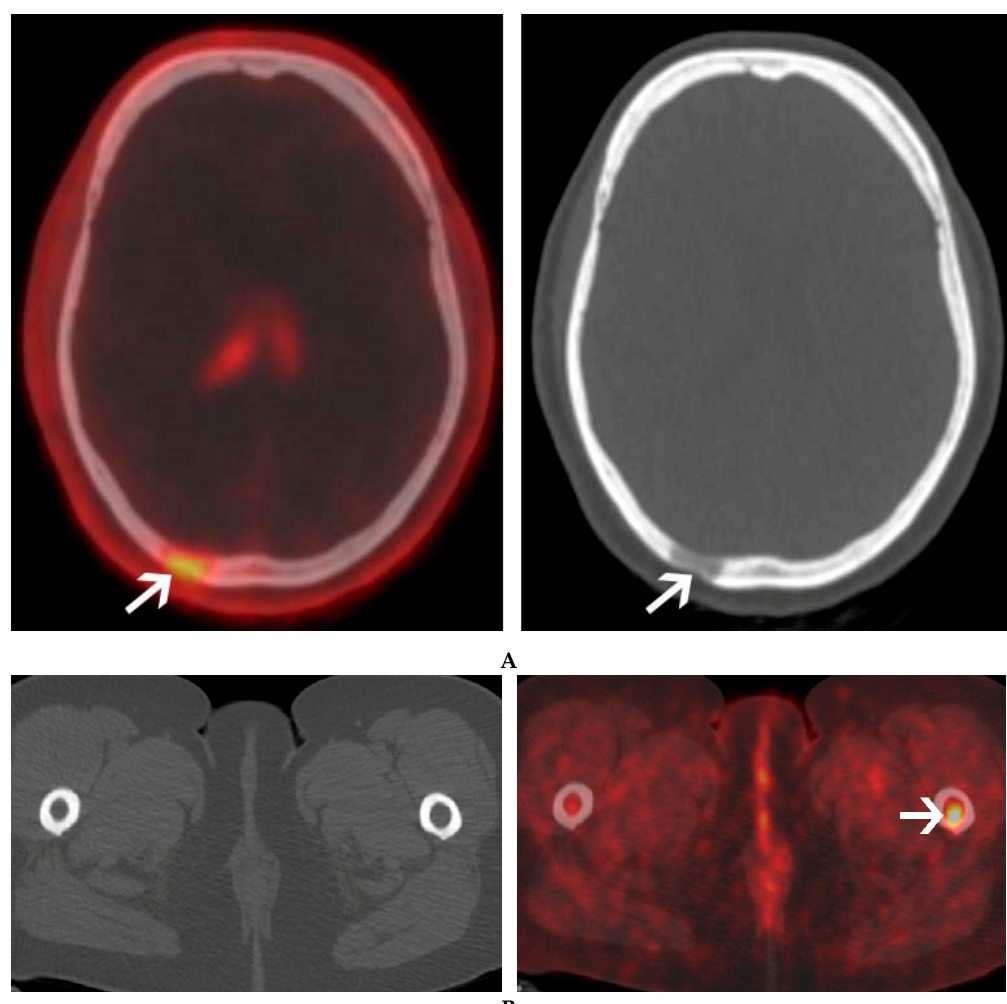
Figure 2. A 60-year-old female with IgG lambda smoldering multiple myeloma. An osteolytic